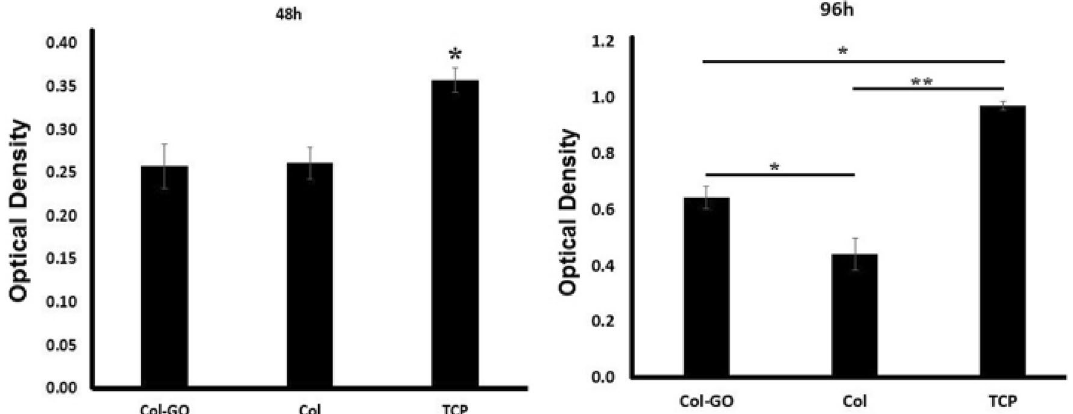
Figure 5. MTT assay results of hBMSCs cultured on Col, Col-rGO scaffolds and TCP group. *(p < 0.05) and **(p < 0.01) indicate significant difference compared with other groups. Data were presented as the average ± standard deviation (n = 3/group).